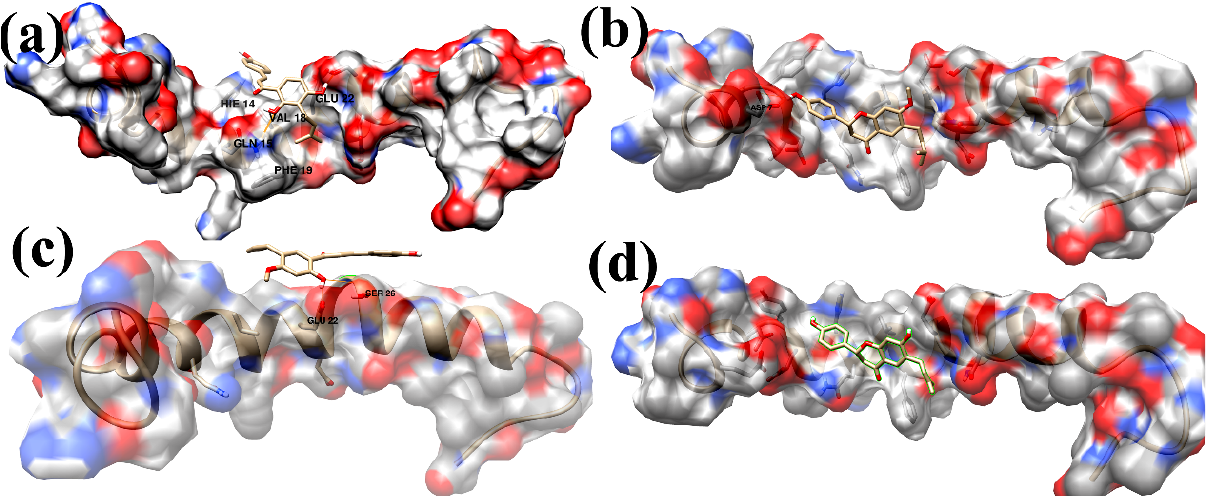
Figure 6. The representative complex structure of AB42-binders as determined by the averaged structure from the last 10 ns MD simulation. The hydrogen bonds are shown in orange solid lines. Compounds 1 – 4 , ( a – d ), are shown in a stick representation. The interacting residues and com ‐ pounds 1 – 4 are shown in a stick representation. Table 2. Calculated binding free energies (kcal mol − 1 a ).